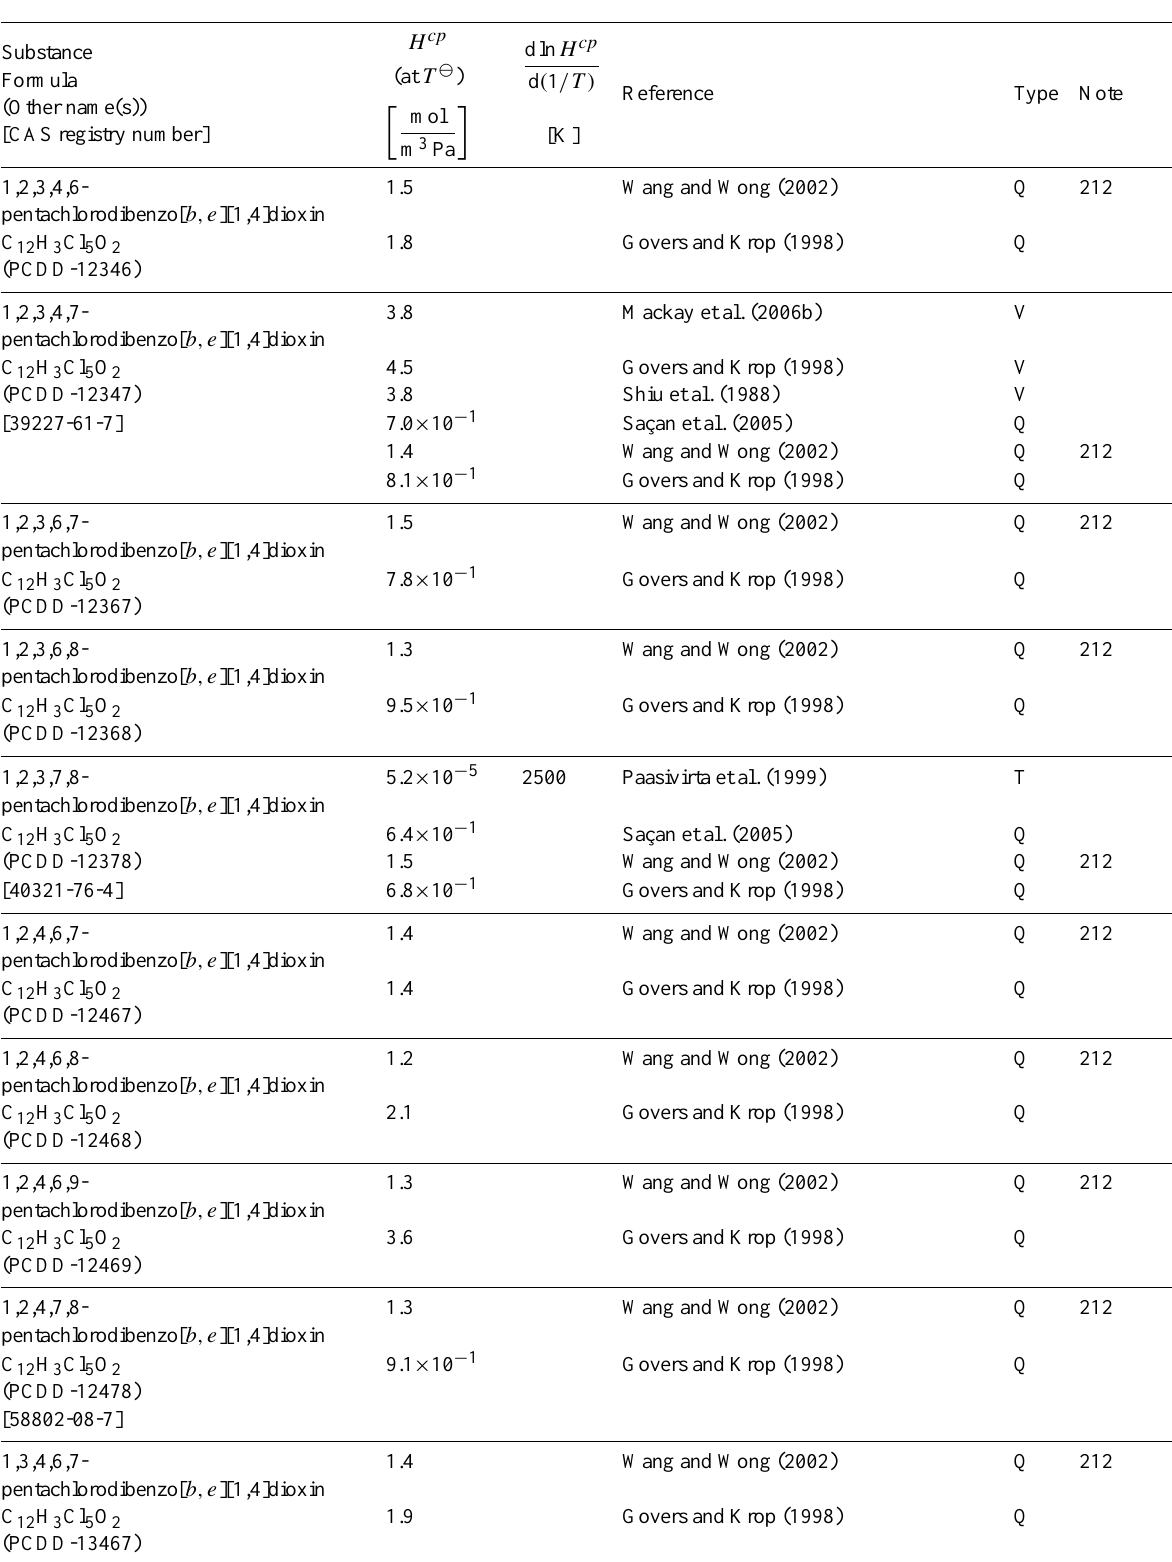
Table 6: Henry’s law constants for water as solvent